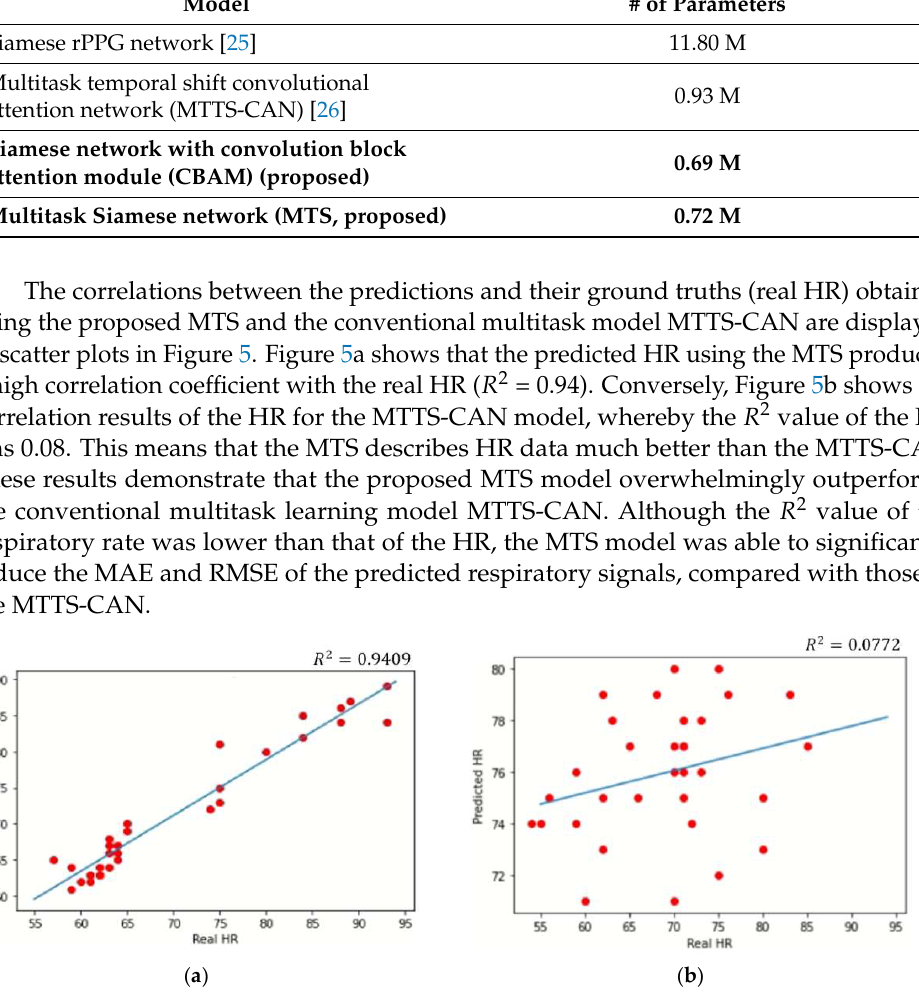
( b ) Figure 6. Examples of the predicted PPG and respiratory signals. ( a ) An example of the predicted PPG signal. ( b ) An example of the predicted respiratory signal. Predicted PPG and respiratory sig- nals are plotted in red lines and their true labels in blue lines. Note the high similarity of the MTS model’s predictions to the true labels. It has been demonstrated that the proposed MTS model outperforms the single-task Siamese networks with the CBAM. For a more rigorous investigation of the MTS and sin- gle-task Siamese network model’s learning processes, their learning curves were gener- ated and are illustrated with their loss values in Figure 7. As can be seen in Figure 7c, the MTS has only one learning curve for the predictions of both PPG and respiratory signals